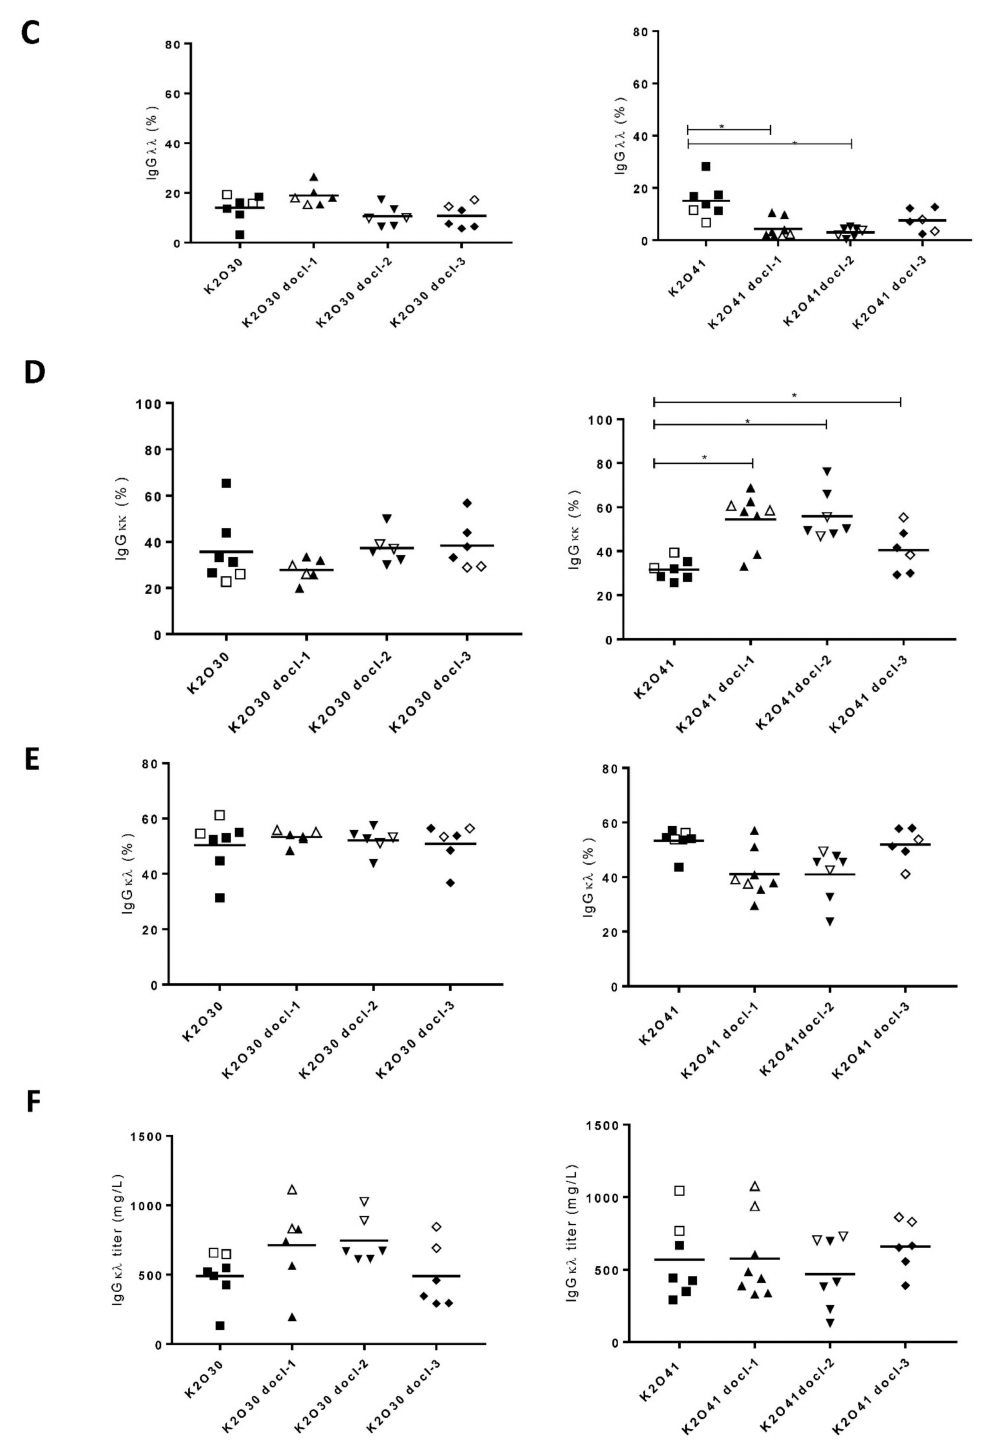
Figure 3. Analysis of IgG ratios and yields in the supernatant of stable CHO pools transfected with K2O30, K2O41 and their respective codon de-optimized variants. Each symbol represents an independent pool. Open symbols indicate the two highest IgG κλ producing pools for each variant. ( A ) Total IgG titers in the supernatants. ( B ) Percentage of lambda light chain determined using the Agilent Bioanalyzer 2100. ( C – E ) Percentage of different IgG forms in total IgG after one step of purification analyzed by HIC-HPLC. ( F ) IgG κλ titers in the supernatants. (*) represent a p value of < 0.5 using one way analysis of